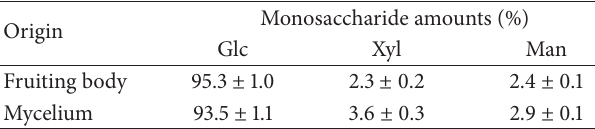
Table 2: Monosaccharide analysis (Glc: glucose; Xyl: xylose; Man: mannose) of ASP (alkali-soluble) preparations extracted from fruit- ing body and vegetative mycelium of C. unicolor .